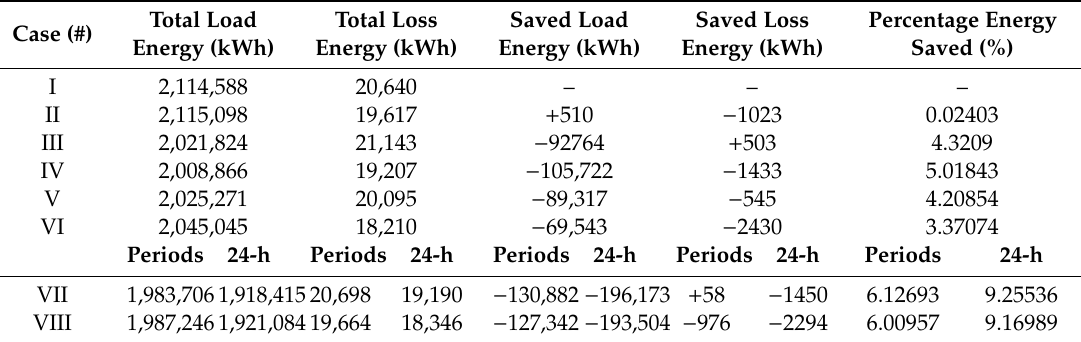
Table 12. Comparison of the di ff erent cases in terms of saved energies and